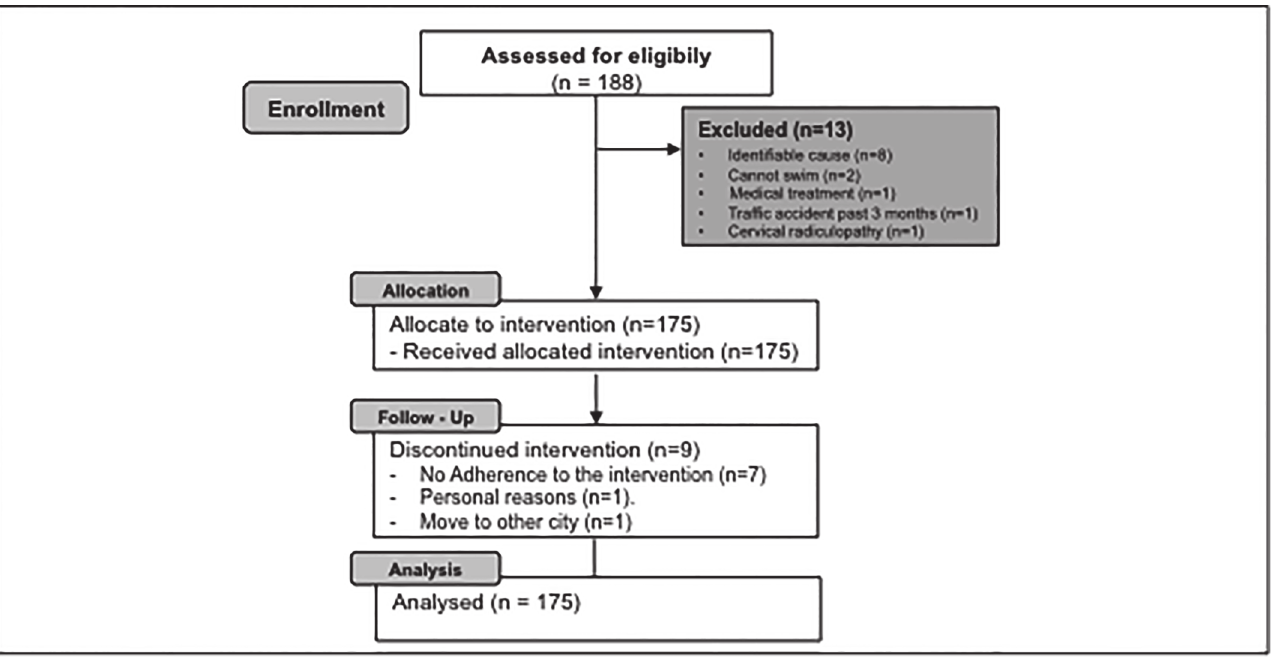
Fig 1. Flowchart of patient enrollment.